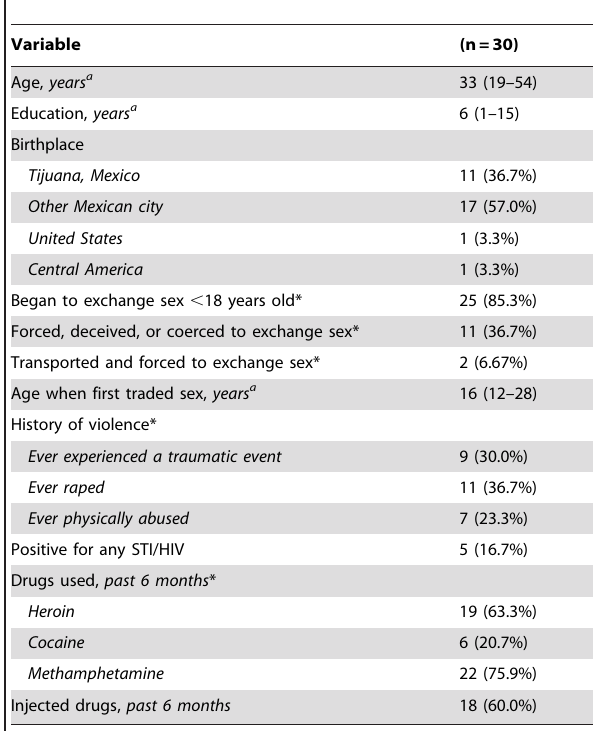
Table 1. Participant characteristics (N=30),